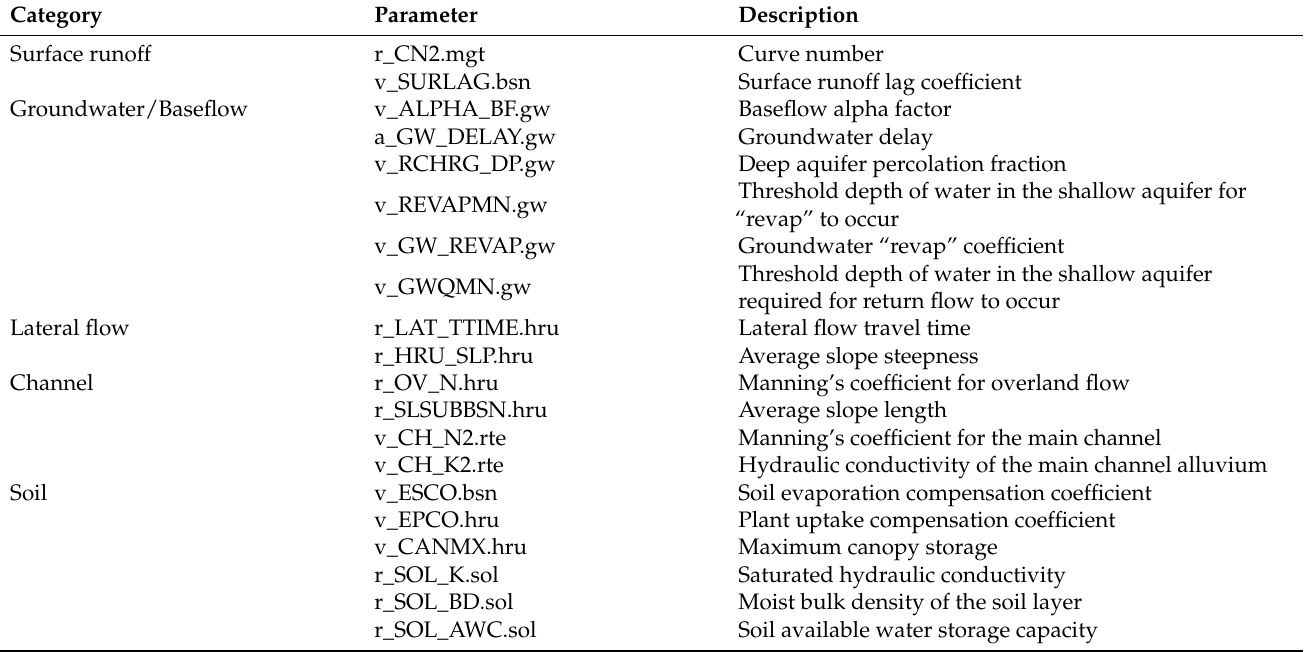
Table 1. Calibrated parameters. The method “r” (relative) indicates multiplying the current parameter value by a given value, the method “v” (replace) indicates replacing the current parameter value, and the method “a” (absolute) indicates adding a given value to the current parameter